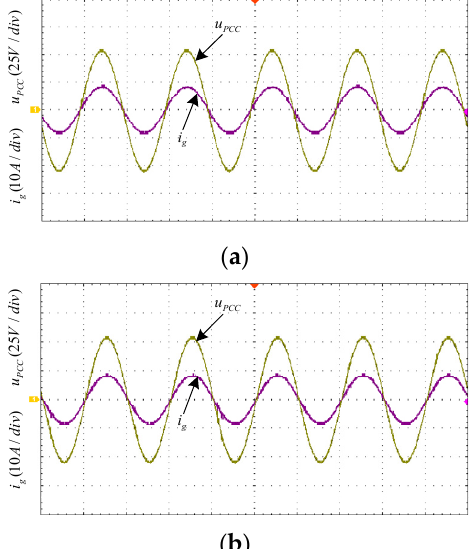
Figure 17. Experimental waveform of current and voltage at PCC for different SCR after impedance